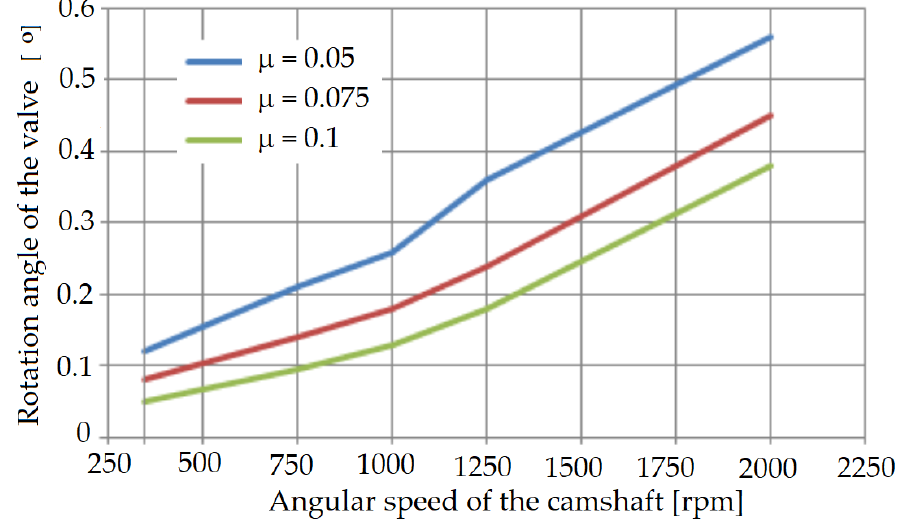
Figure 17. The influence of the coefficient of friction on the angle of rotation of the valve.